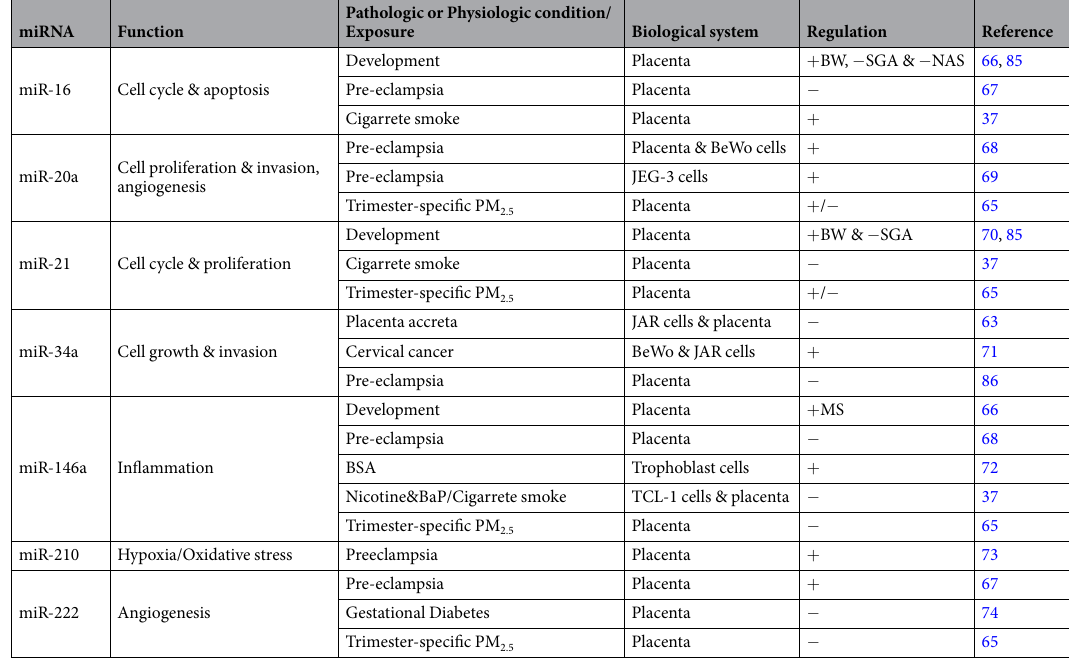
Table 1. Relevant studies of the studied candidate miRNAs on human placental tissue or cell lines. BW: birth weight, NAS: neonatal attention scores, SGA: small gestational age, BeWo, JEG-3 & JAR cells: trophoblast choriocarcinoma cell lines, TCL-1 cells: extravillous trophoblast from choriodecidua of a term placenta, MS: movement scores, BSA: bisphenol A, BaP: